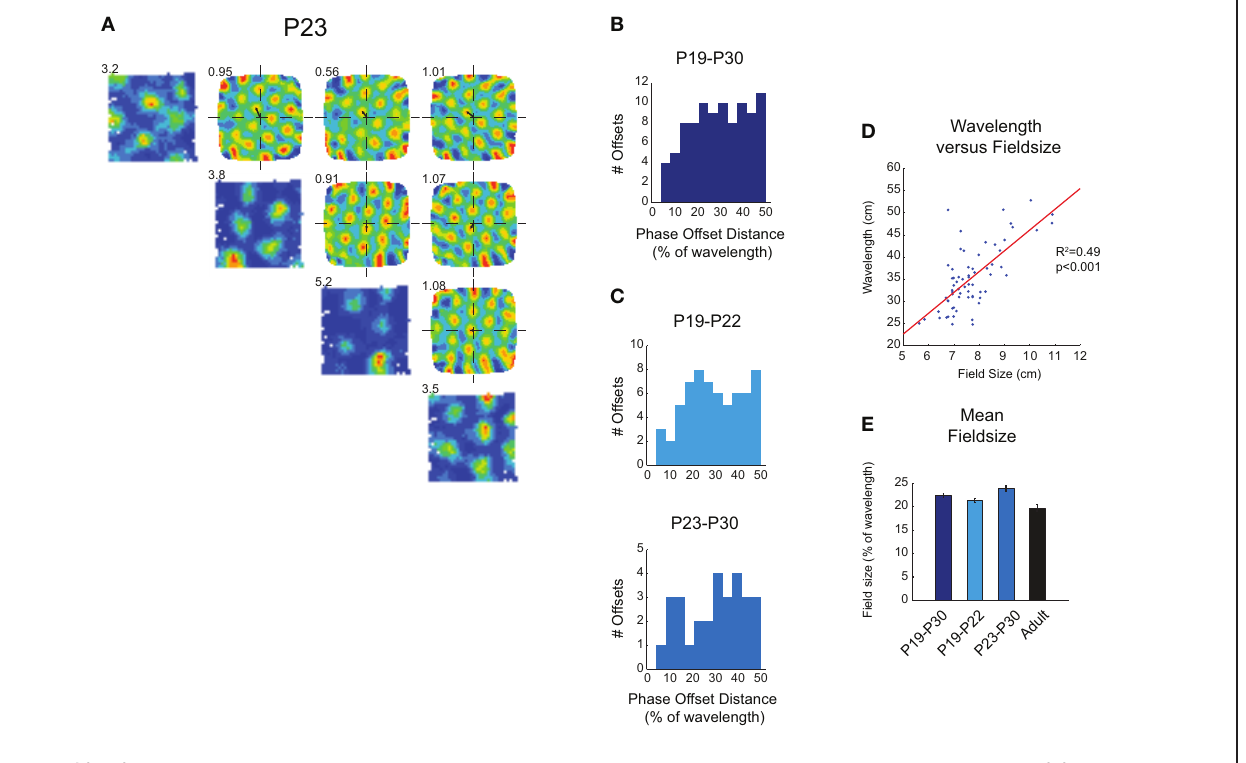
gridness score calculated from the cross-correlogram. (B) Phase offsets for all simultaneously recorded grid cells from P19 to P30. Offsets are evenly distributed between 0% and 50% of grid wavelength (C) Phase offsets are equally distributed in both younger (light blue) and older (blue-gray) developing rats. (D) Scatter plot showing the wavelength for each grid cell (ages P19–P30) versus the field size. Red line shows significant linear regression between wavelength and field size, R 2 and p -values for regression are shown to left of plot. (E) Mean field size as a percentage of wavelength, ± SEM. Field size in pups is slightly larger than that in adults, but there is no trend for field size to decrease during the period